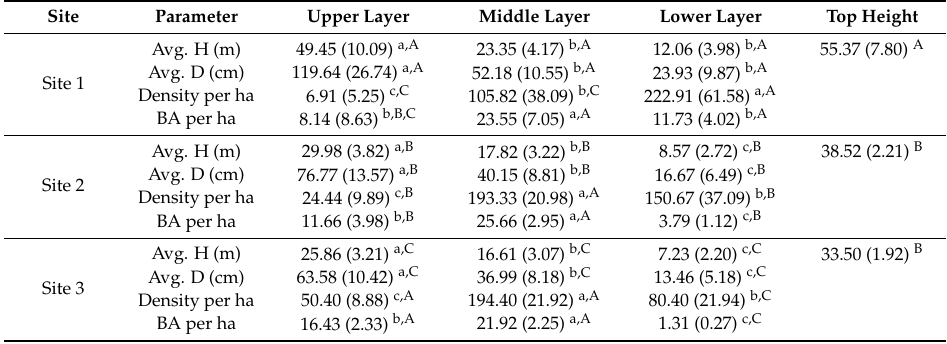
Table 3. Stand characteristics of forests in accordance with different height